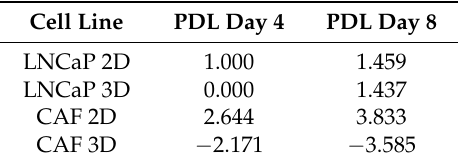
Figure 1. Morphology and size of monoculture spheroids established from prostate cancer (PCa) epithelial cells and PCa-associated fibroblasts (CAFs). LNCaP, LAPC4, DuCaP and CAFs were grown in scaffold-free 96-well hanging drop plates over eight days. ( A ) Representative bright-field images were taken at the day indicated (magnification 10 × , scale bar: 500 µ m); ( B ) mean radius of the spheroids was calculated at day 4 and day 8 as described in Materials and Methods. Error bars denote SEM. Statistical significance is shown; ( C ) Cell viability of 2D monolayer cultures and 3D spheroids was assessed by WST-1 assay, as described in Materials and Methods. Mean absorbance plus SEM was normalized to cell number. * p < 0.05; *** p < 0.001. Table 1. Population doublings (PDL) of LNCaP and CAF in 2D and 3D culture.